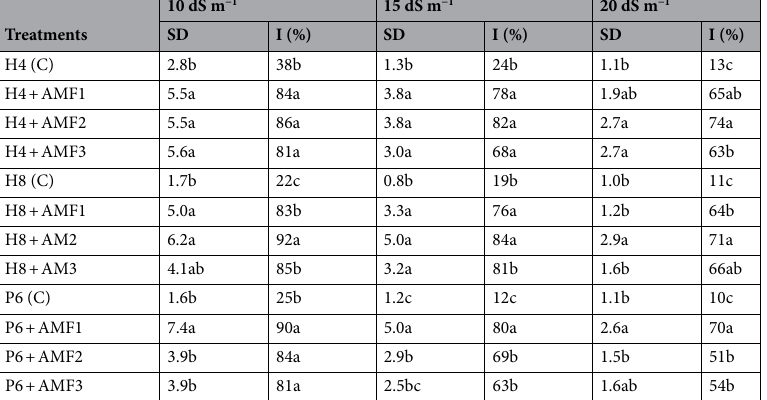
AMF colonization and spore density. Control plants (plants that were not pre-inoculated) were also colonized by AMF, which was caused by the experiment, which, after pre-inoculation or not in sterilized soil, was executed in non-sterile field soil, however, colonization levels were much lower than in the pre-inoculated seedlings. Spore density and fractional root colonization significantly ( P ≤ 0.05) declined with increasing salinity levels (Table 2). Mycorrhizal colonization and spore density were very significantly correlated (r = 0.64; n = 36; P < 0.001). The significant interaction between AMF and salinity level for both parameters (Table 1) indicated that the protective effect of pre-inoculation diminished at higher salinity levels. The interaction between AMF and eucalyptus clone was also significant for fractional root colonization, suggesting species-specific responses to different eucalyptus clones. Root colonization and spore densities with clone H4 and H8 were highest with G. albida , while eucalyptus clone P6 showed highest spore densities and root colonization with Glomus sp.2. AMF are generally characterized as showing little or no host specificity, however plant species or plant variety-specific responses to individual species of AMF have been observed before 26,27 . Our results are consistent with earlier studies that showed that salinity inhibited spore germination, suppressed the growth of hyphae after initial infec- tion, and reduced the number of arbuscules 28–31 . Plant performance. Both AMF and salinity were significant sources of variation for root and shoot bio- mass, whereas clone was only a significant source of variation for root parameters. The interaction between AMF and clone was also significant, again demonstrating AMF species-specific responses in combination with differ- ent clones (Table 1). Salinity decreased plant performance parameters, with a larger effect at higher salinity lev- els, whereas pre-inoculated plants produced more biomass than control plants. At all salinity levels, plants pre- inoculated with G. albida usually showed higher biomass than plants pre-inoculated with the other AMF species (Table 3). However, at the salinity level of 15 dS m −1 , eucalyptus clone P6 pre-inoculated with Glomus sp.2, was significantly heavier than when pre-inoculated with the other AMF species. These data fit with the selectivity of the different AMF for different clones as assessed by fractional root colonization and spore density. Negative effects of salinity have been reported for many glycophytes, such as Allium cepa L., Medicago sativa L., Triticum aestivum L. and Hordeum vulgare L. 28,29,32 and the alleviation of these negative effects of salinity by AMF, and plant and fungal species specificity with respect to this protective effect has also regularly been reported 31,33–35 . Leaf relative water content (LRWC) was also significantly affected by salinity (S), AMF, eucalyptus clone (C), and the interaction of AMF × C and S × C (Table 1). Salinity reduced, but mycorrhizal plant increased LRWC. Again, eucalyptus clone H8 that was pre-inoculated with G. albida and clone P6 pre-inoculated with Glomus sp.2, showed the highest positive mycorrhizal effect (Table 3). There are several reasons why the AMF plants have a higher LRWC, (1) AMF roots have higher hydraulic conductivity at low water potential 36 ; (2) AMF induce alterations to the root system 37 ; (3) mycorrhizal plants have higher stomatal conductance 38 ; (4) AMF accumulate solutes and improve plant osmotic adjustment 39 , and (5) improved water relation by AMF hyphae 40 . Root length and root surface area were both significantly affected by salinity level, AMF and interaction of AMF × C. In the case of root surface area, the interaction of S × C was also significant (Table 1). Root length was significantly positively correlated with LRWC. Root diameter showed a significant negative correlation with root length, specific root length, and root tissue density (Table 4). Salinity reduced, and pre-inoculation with mycorrhiza increased, root length and root surface area (Table 3). Seedlings pre-inoculated with Glomus sp.2 had larger root diameter than control seedlings and seedlings pre-inoculated by both Gigaspora species, an effect described before 41 and likely due to hormonal effects.